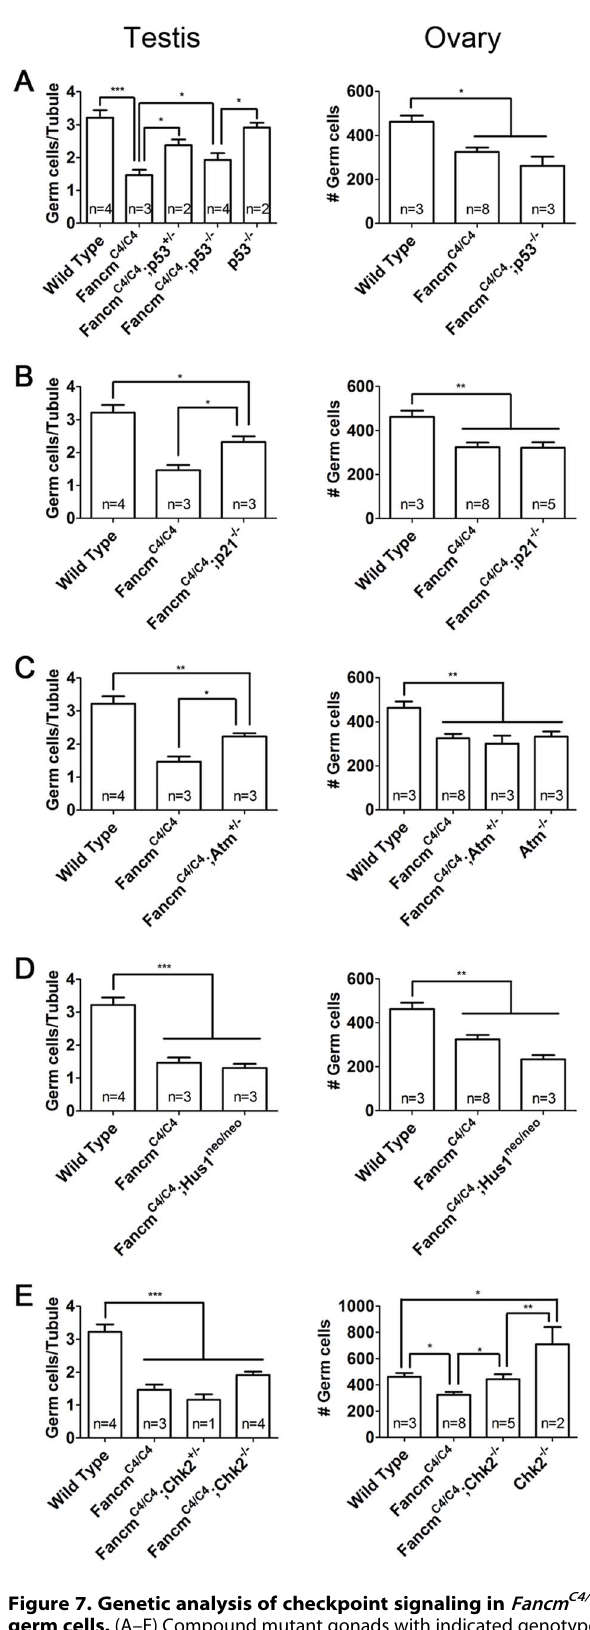
Figure 7. Genetic analysis of checkpoint signaling in Fancm C4/C4 germ cells. (A–E) Compound mutant gonads with indicated genotypes were collected at 1 dpp. Germ-cell counts were performed following MVH labeling. Male germ cell number was averaged on a per